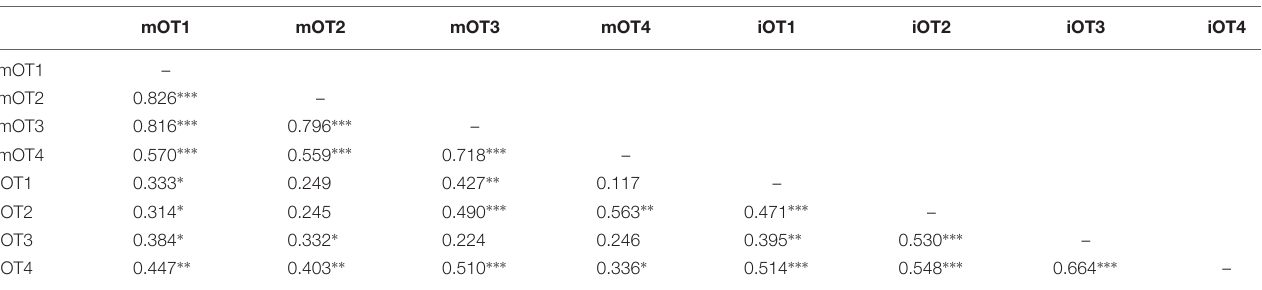
TABLE 5B | Bivariate relations between maternal and infant baseline OT at the four time points (imputed data). mOT1 mOT2 mOT3 mOT4 iOT1 iOT2 iOT3